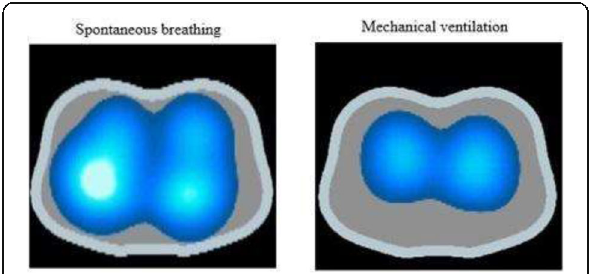
Fig. 1 (abstract 0274). Ventilation distribution images delivered by EIT in spontaneous breathing and mechanical ventilation